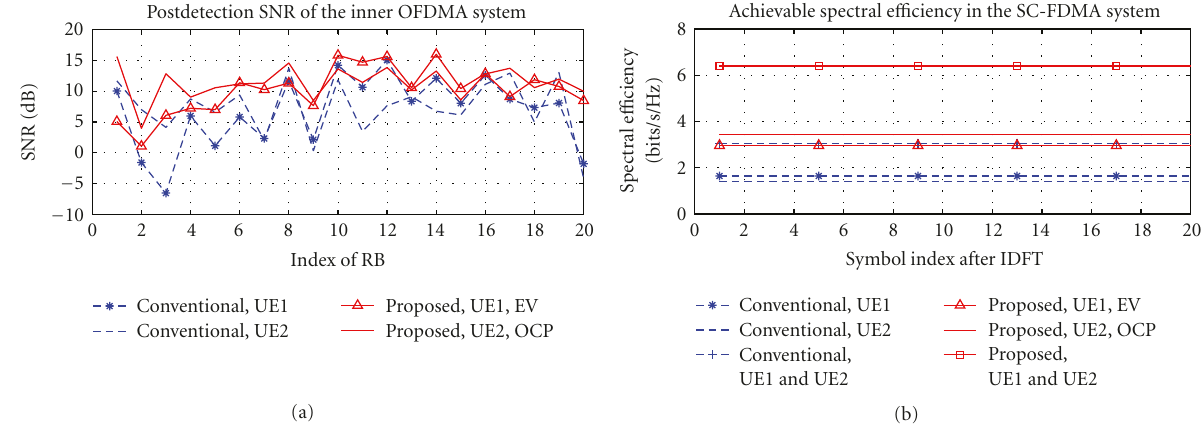
Figure 4: Performance comparisonbetween the conventionalvirtual MIMO SC-FDMA and the proposed MIMO SC-FDMA with precoding using the channel snapshot in Figure 3. (Upper: postdetection SNR of the inner OFDMA system; Lower: achievable spectral e ffi ciency in the SC-FDMA